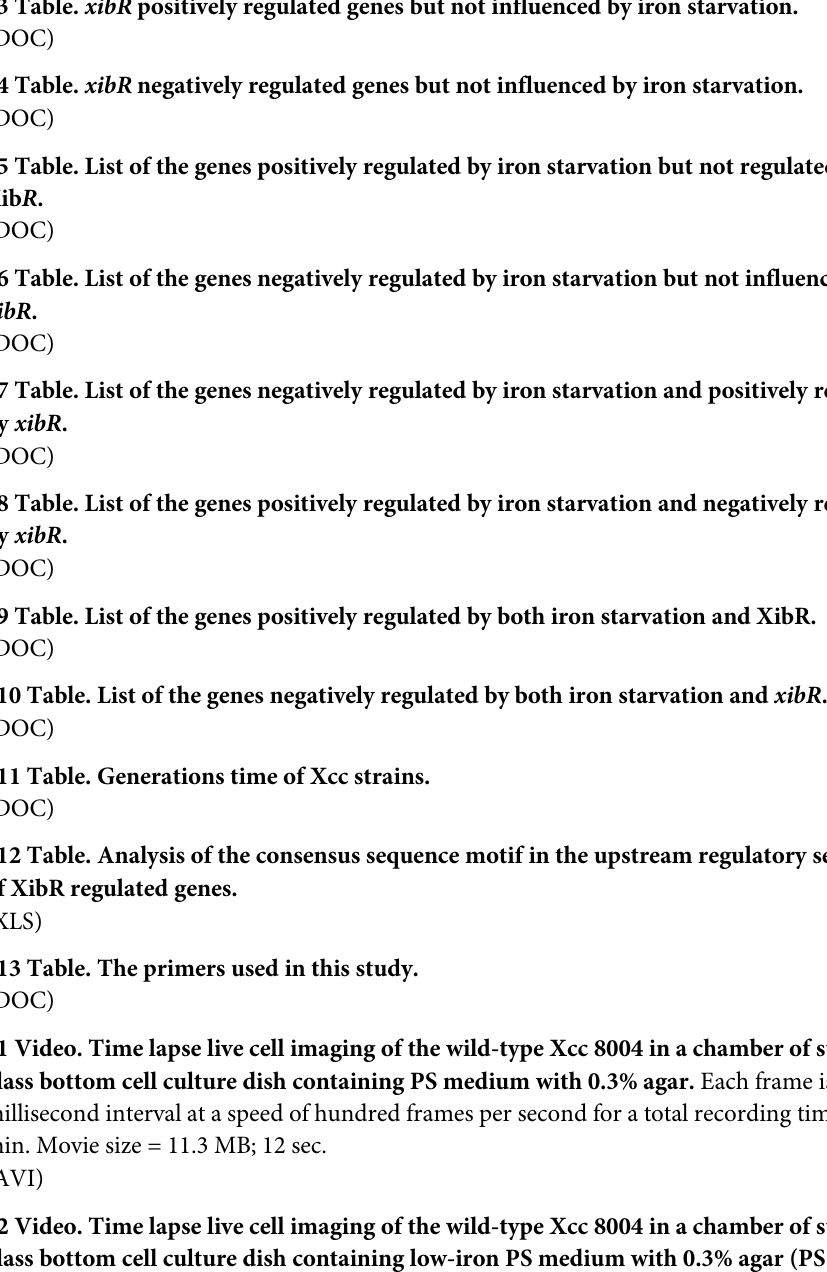
S1 Table. Insertional mutants of Xanthomonas campestris pv. campestris with altered side- rophore production. S2 Table. Strains and plasmids used in this study. S3 Table. xibR positively regulated genes but not influenced by iron starvation. S4 Table. xibR negatively regulated genes but not influenced by iron starvation. S5 Table. List of the genes positively regulated by iron starvation but not regulated by Xib R . S6 Table. List of the genes negatively regulated by iron starvation but not influenced by xibR . S7 Table. List of the genes negatively regulated by iron starvation and positively regulated by xibR . S8 Table. List of the genes positively regulated by iron starvation and negatively regulated by xibR . S9 Table. List of the genes positively regulated by both iron starvation and XibR. (DOC) S10 Table. List of the genes negatively regulated by both iron starvation and xibR . (DOC) S11 Table. Generations time of Xcc strains. S12 Table. Analysis of the consensus sequence motif in the upstream regulatory sequences of XibR regulated genes. S13 Table. The primers used in this study. (DOC) glass bottom cell culture dish containing PS medium with 0.3% agar. Each frame is of 300 millisecond interval at a speed of hundred frames per second for a total recording time of 4 min. Movie size = 11.3 MB; 12